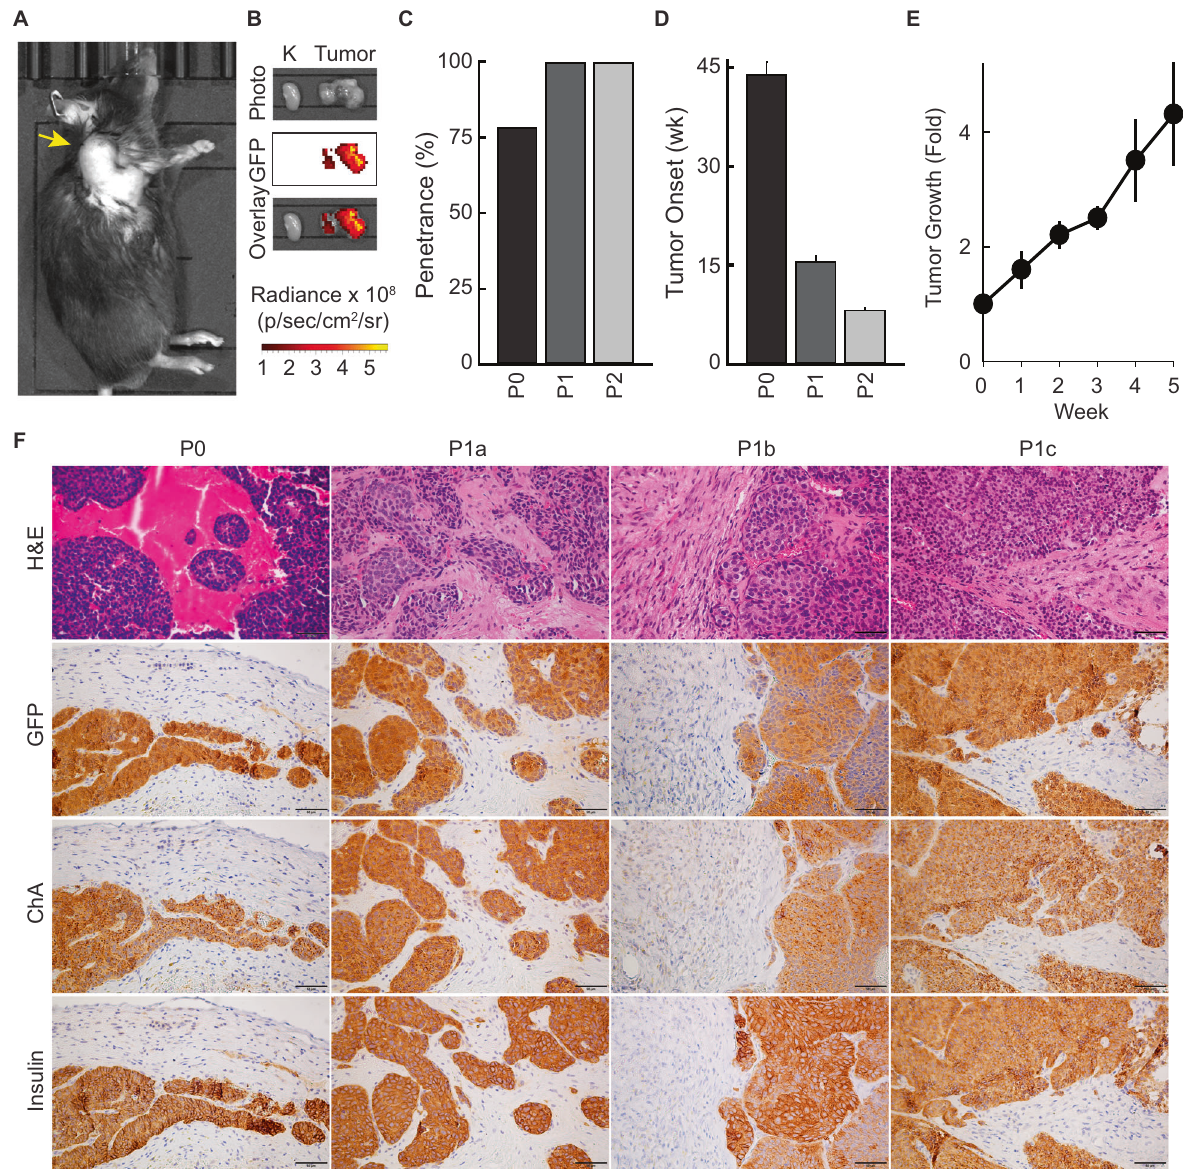
Fig. 6 INS-p25OE PanNETs form successful allografts. A Photograph from IVIS image of representative allograft tumor model; tumor marked with yellow arrow. B Photograph and fl uorescence imaging from IVIS, ex vivo, of kidney (left) and tumor (right) from representative allograft model. C Penetrance in primary INS-p25OE model (P0), passage 1 models (P1), and passage 2 models (P2). D Tumor onset in the same groups as C (P0, n = 21; P1, n = 5; P2, n = 5). E Fold growth of passage 1 tumors over a 5 week period starting at ~100 mm 3 (week 0) (weeks 0 – 3, n = 6; weeks 4 – 5, n = 5). F H&E stains and immunostains of primary INS-p25OE model (P0) and three passage 1 models